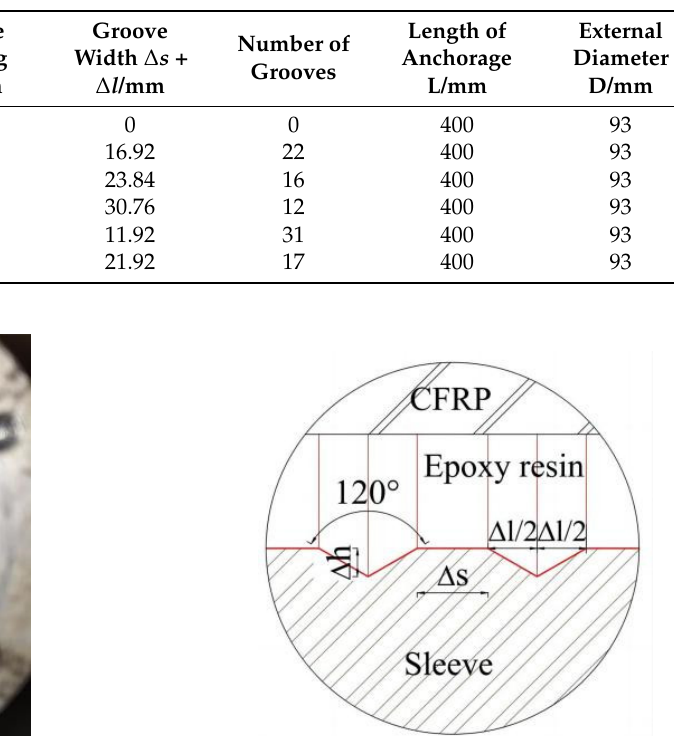
Table 2. Specimen parameters of static tensile test.